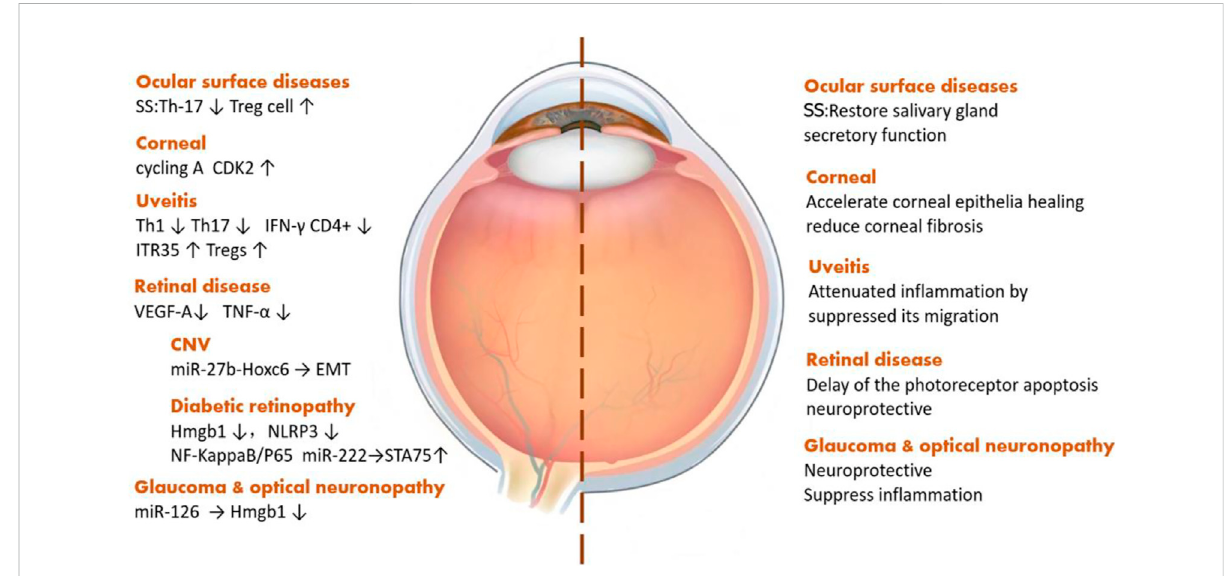
FIGURE 3 Exosomes derived from stem cells play different roles in ophthalmic diseases.